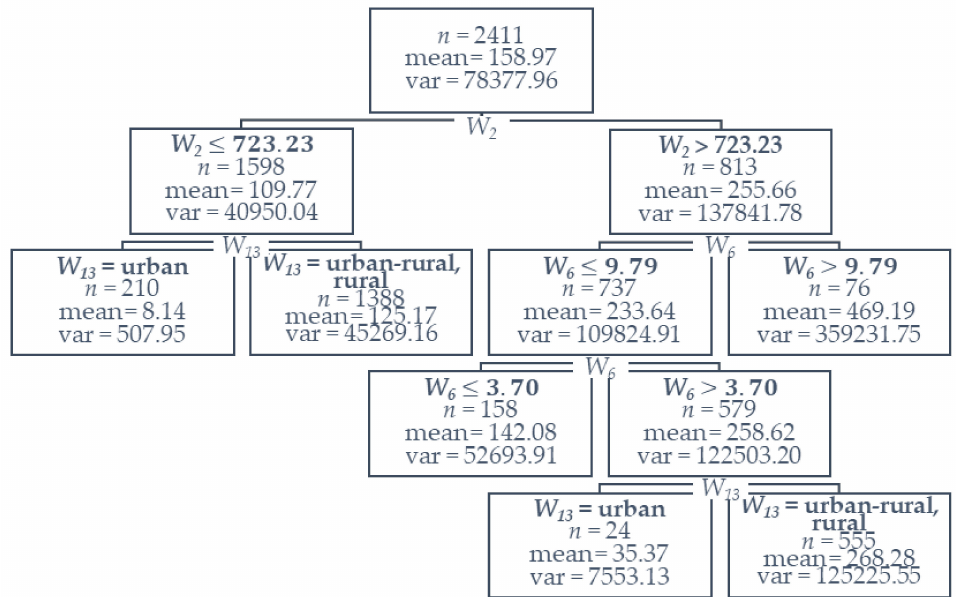
Figure 5. Regression tree for the indicator W 1 at the commune level. Source: The authors’ calculations in Statistica 13 , based on data of: KOWR and